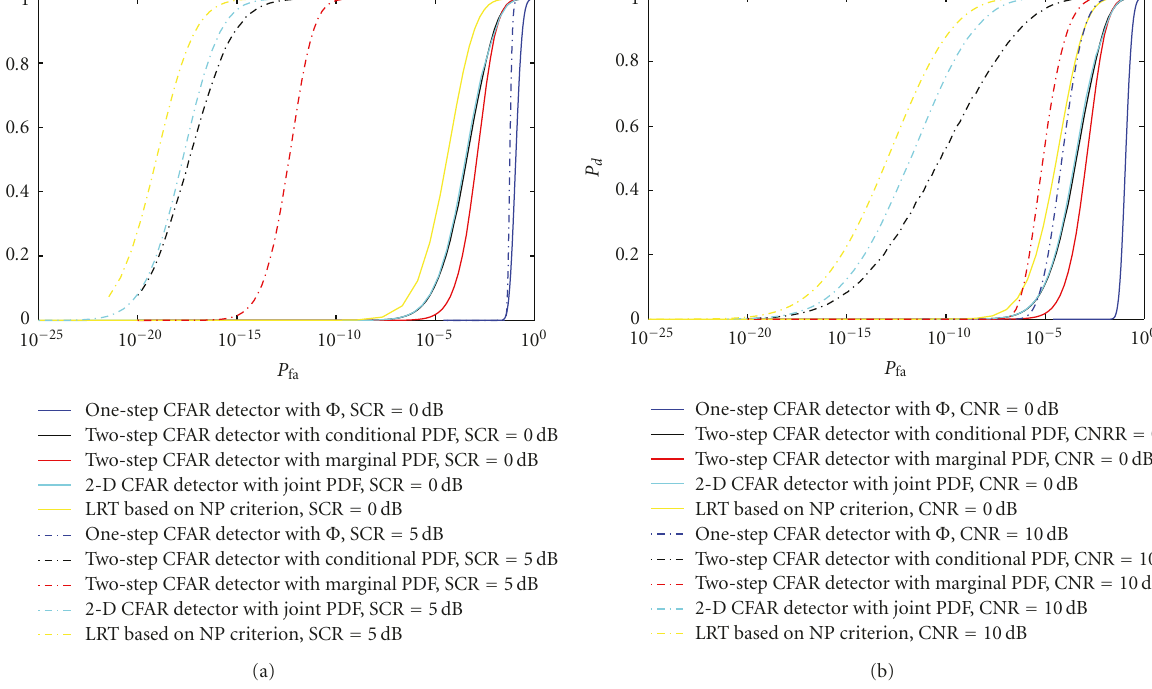
Figure 9: Performance of ATI detectors for SCRs and CNRs, n = 10, Φ v = 1rad (one-step CFAR detector with, two-step CFAR detector with conditional PDF, two-step CFAR detector with marginal PDFs, 2D CFAR detector with joint PDF, and LRT based on NP criterion). (a) CNR = 0 dB, SCR = 0dB, 5dB; (b) SCR = 0dB, CNR = 0dB, 10